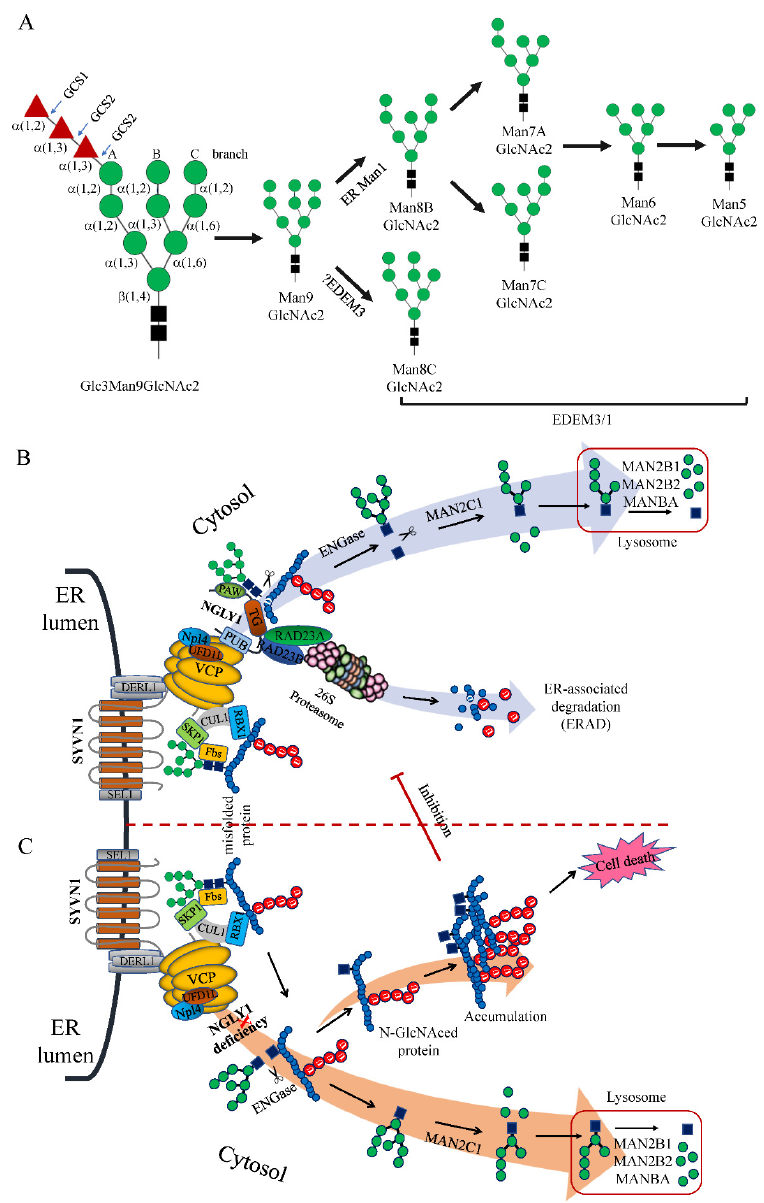
Figure 5. Glc3Man9GlcNAc2 trimming process and ER-associated degradation pathway (ERAD) involving NGLY1. ( A ) Glc3Man9GlcNAc2 trimming process; ( B ) ERAD under normal physiological state; ( C ) ERAD with NGLY1 deficiency.